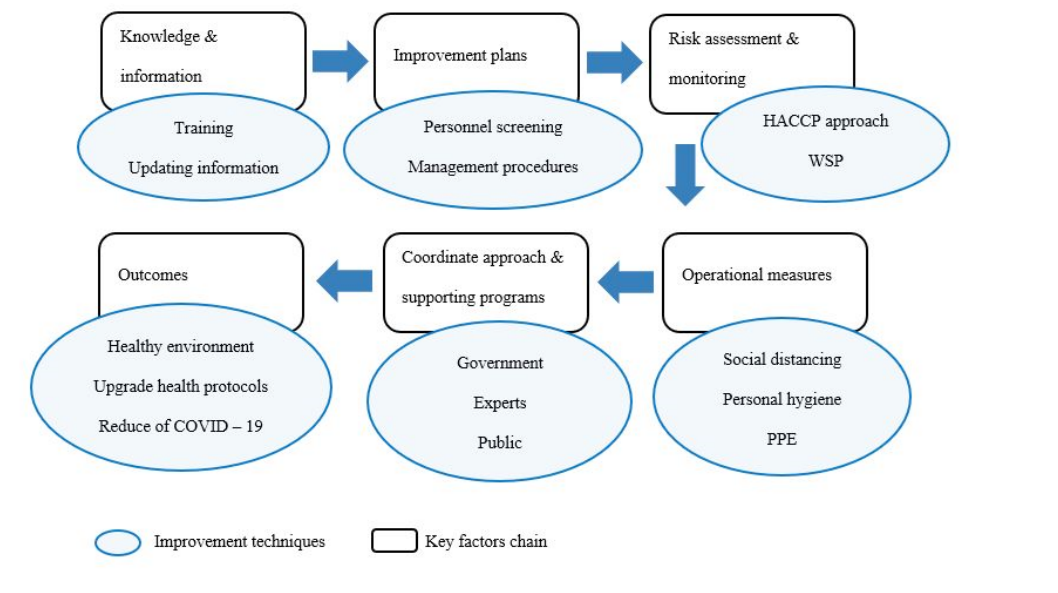
Figure 1. COVID-19 prevention